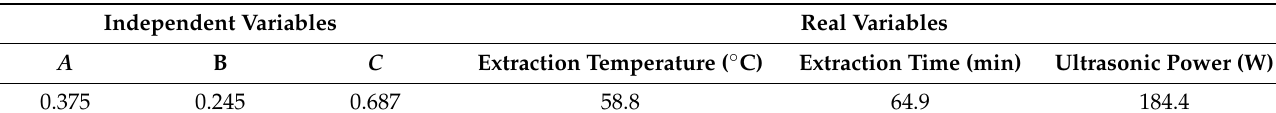
Table 5. The values of the independent variable and real variables.